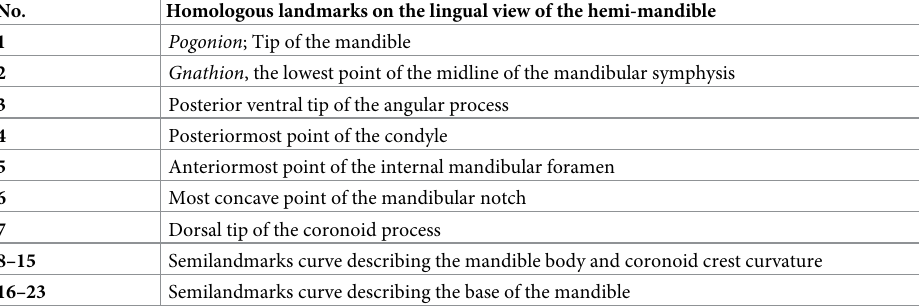
Table 2. Description of the 7 homologous landmarks used in the geometric morphometrics analysis of 85 mono- dontid 2D hemi-mandibles.